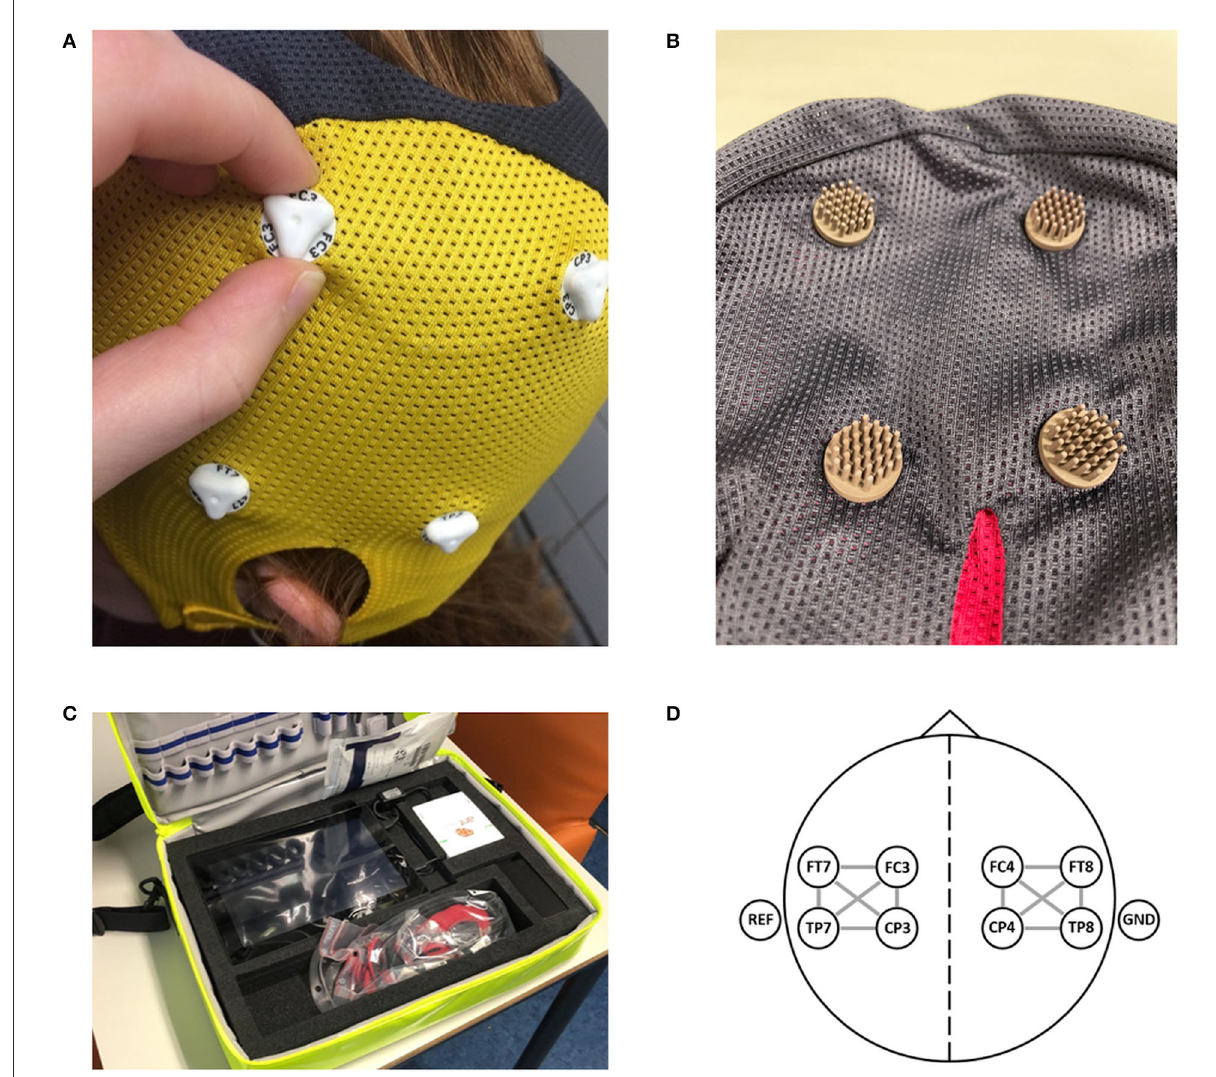
FIGURE2 The equipment as used in the ELECTRA-STROKE study. (A) The 8-channel dry electrode cap (Waveguard touch, Eemagine, Berlin, Germany). (B) The multipin Ag/AgCl coated dry electrode. (C) The portable and lightweight EEG equipment, including the dry electrode EEG cap